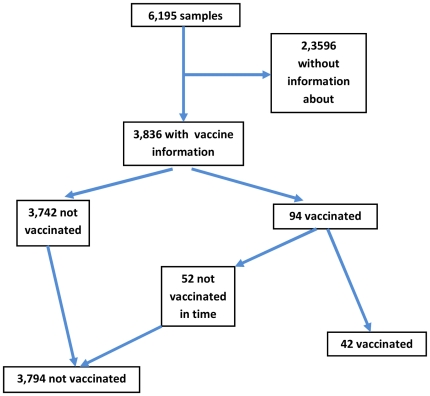
Breakdown of population according to vaccination status, test-negative case-control method.